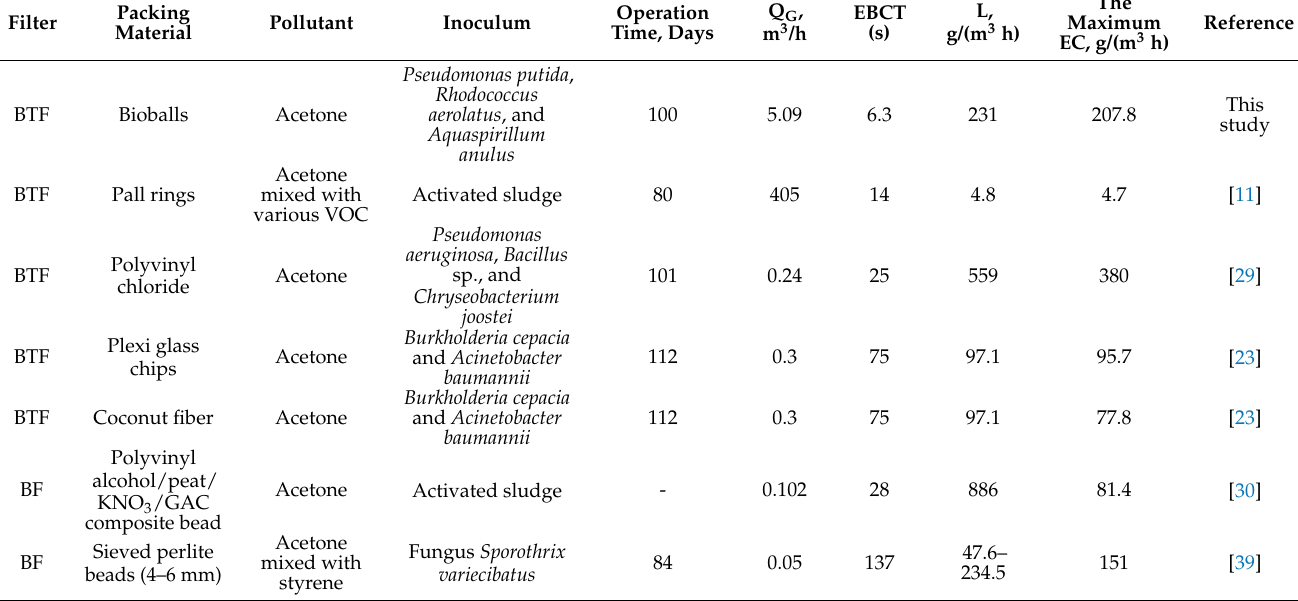
Table 2. Maximum acetone elimination capacities by various biofiltration